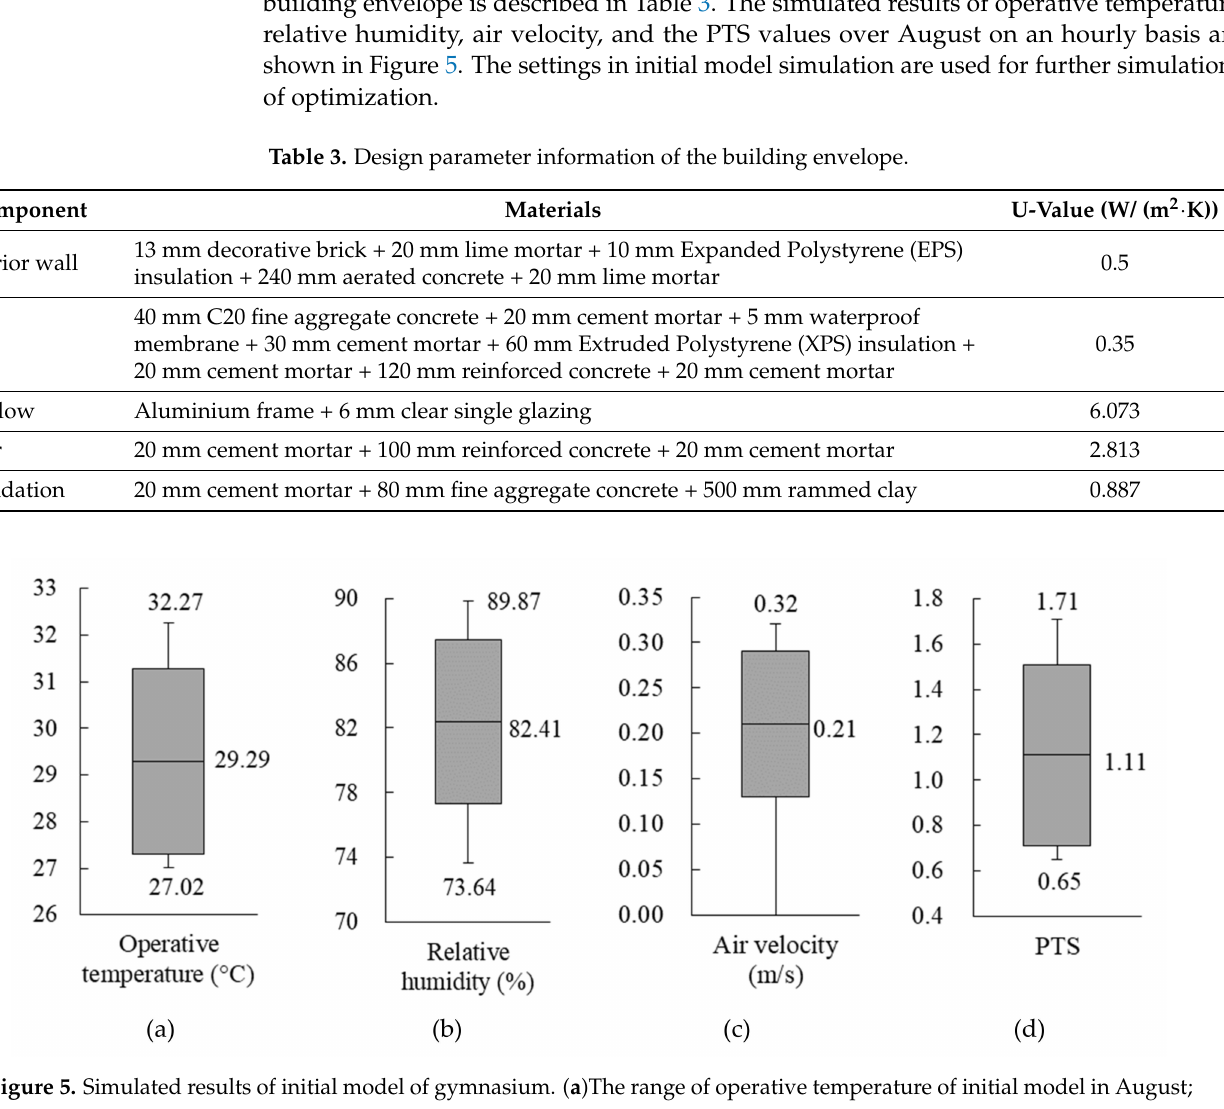
Figure 5. Simulated results of initial model of gymnasium. ( a )The range of operative temperature of initial model in August; ( b ) The range of relative humidity of initial model in August; ( c ) The range of air velocity of initial model in August; ( d ) The range of Predicted Thermal Sensation of initial model in